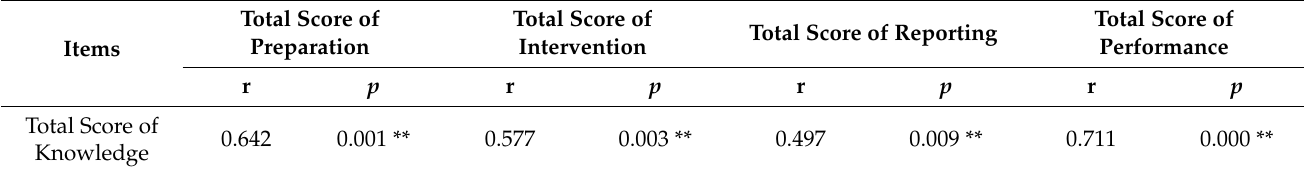
Table 5. Correlation between studied variables (N =